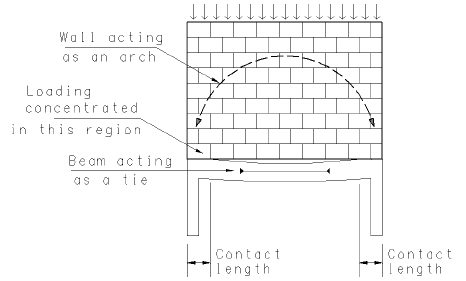
Figure 1. Continuous action of the wall-beam system. Adapted from Barbosa